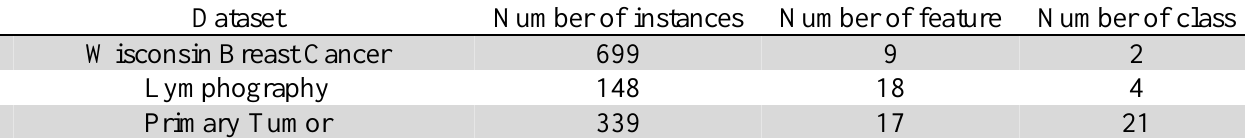
Specifications of datasets under